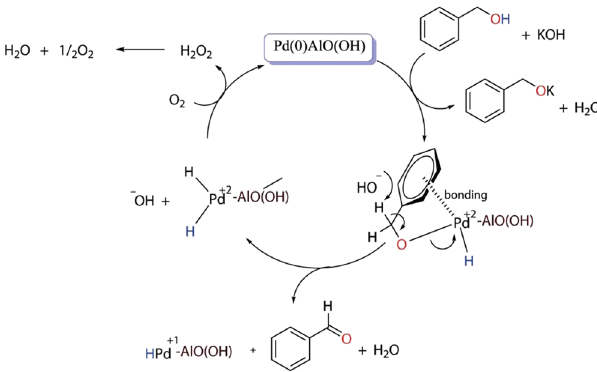
Figure 6. Proposed mechanism for the oxidation of benzyl